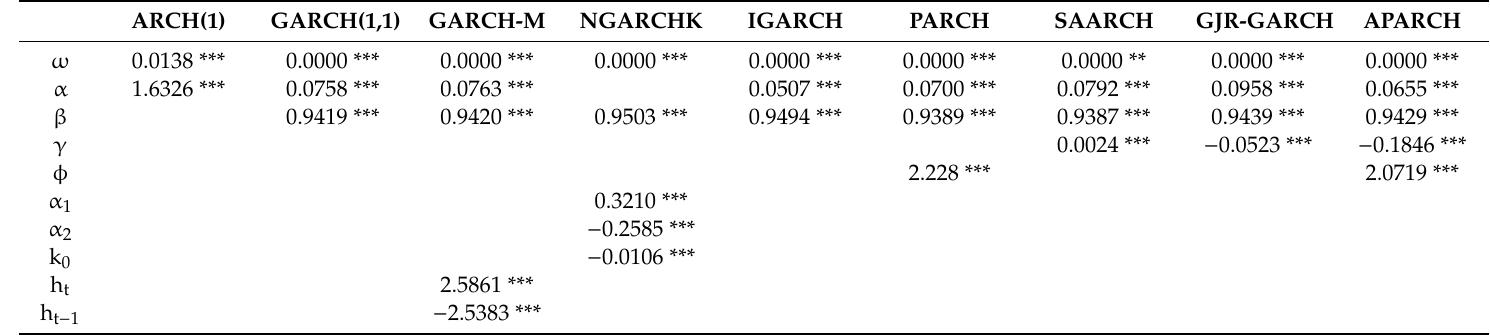
Table 4. GARCH estimations and diagnostic tests for SREC prices. *** and ** denote significance at the 1% level and 5% level,